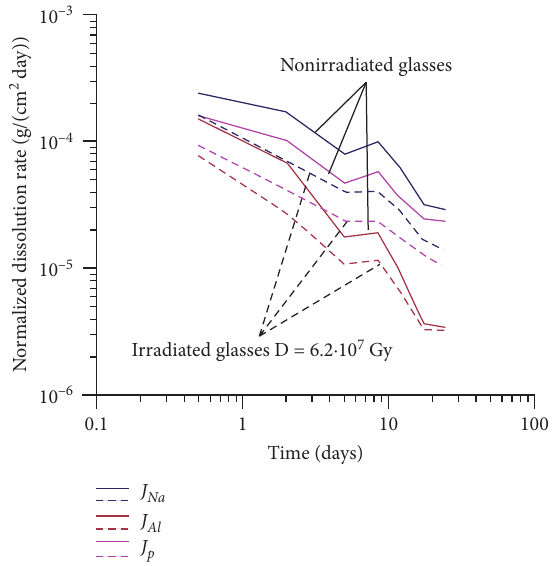
Figure 8: Effect of irradiation on elements with normalized leaching rates from the NAP glass at 90 ° S . Table 10: Ratios of leaching rates J E l ( t ) of nonirradiated and ir- radiated NAP